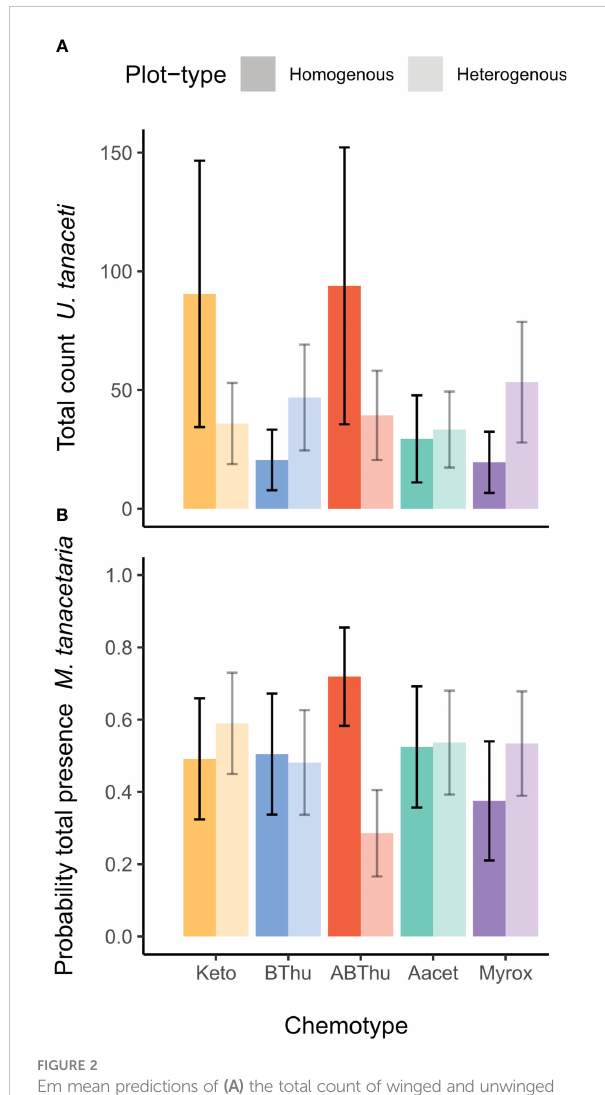
FIGURE 2 Em mean predictions of (A) the total count of winged and unwinged individuals of Uroleucon tanaceti and (B) the probability of presence of winged and unwinged individuals of Macrosiphoniella tanacetaria on plants of Tanacetum vulgare grown in plots of fi ve individuals of the same (homogenous) or different (heterogenous) chemotypes (Keto, artemisia ketone chemotype; BThu, b -thujone chemotype; ABThu, a -/ b -thujone chemotype; Aacet, artemisyl acetate/artemisia ketone/ artemisia alcohol chemotype; Myrox, ( Z )-myroxide/santolina triene/ artemisyl acetate chemotype). A signi fi cant [ (A) : p = 0.01, (B) : p = 0.02] chemotype x plot-type interaction was found based on the conditional (A) and zero-in fl ation (B) component of the zi-GLMM. Number of observations per chemotype x plot-type interaction n obs = 200-240 and plants per chemotype x plot-type interaction n plants = 25-30.